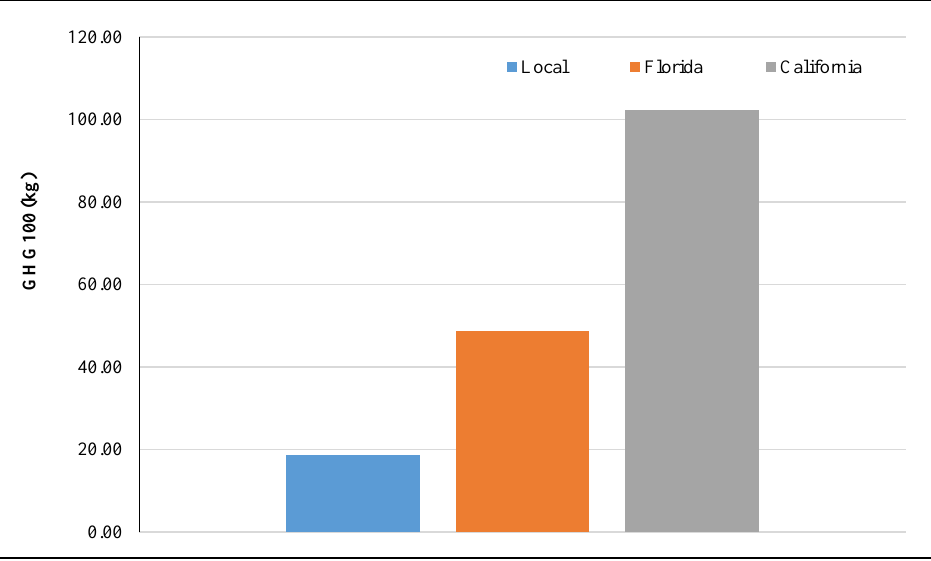
Figure 6. Overall GreenHouse Gas (GHG) emissions from strawberry